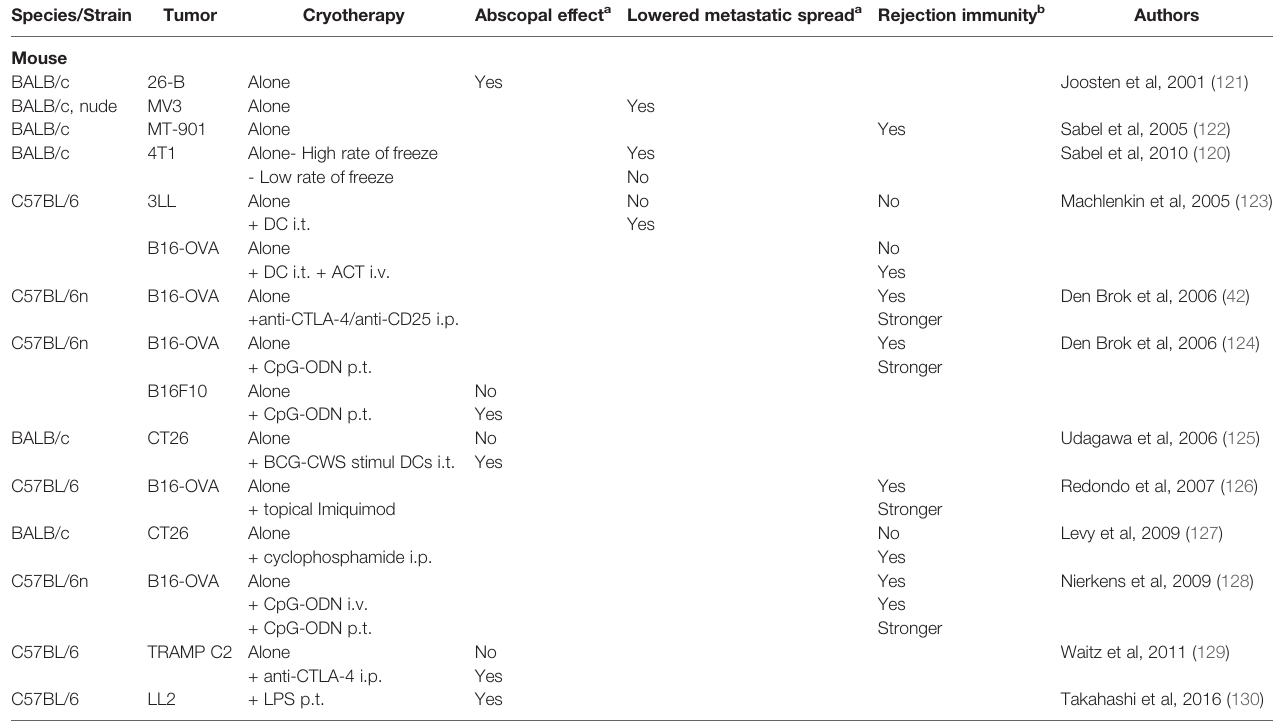
TABLE 3 | Effect on systemic disease after cryotherapy in animals. Species/Strain